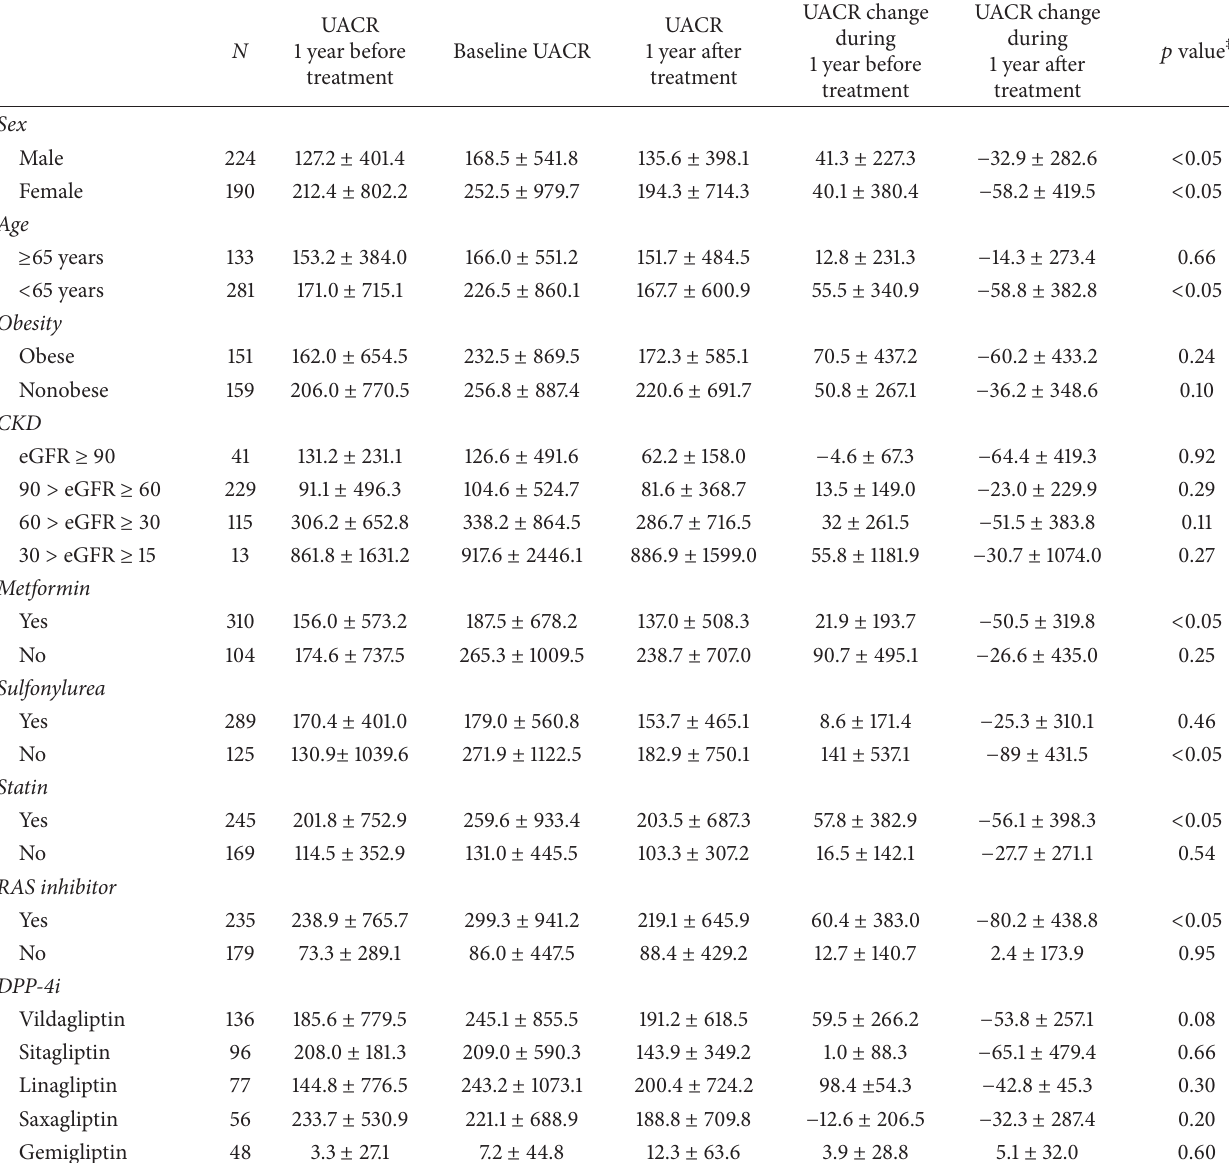
Table 4: Subgroup analysis for sex, age, obesity, chronic kidney disease stage, and drug coadministration. UACR N 1 year before